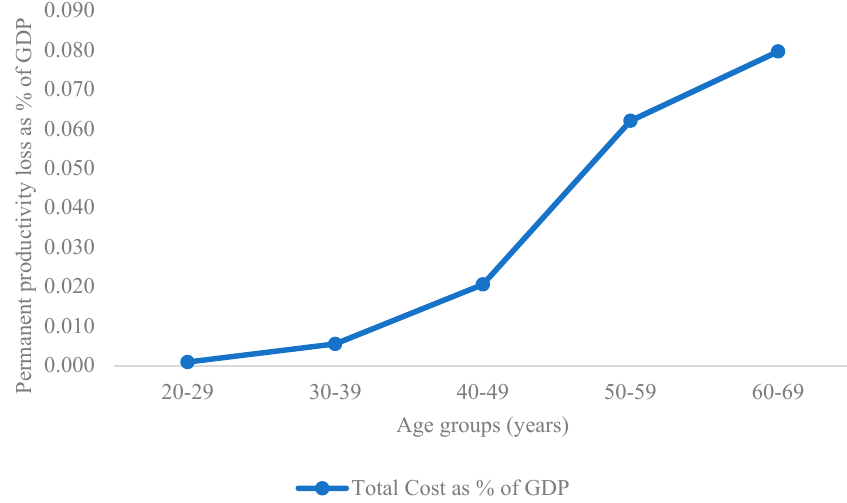
Figure 2. Permanent Productivity Loss as a % of GDP for each working age class.